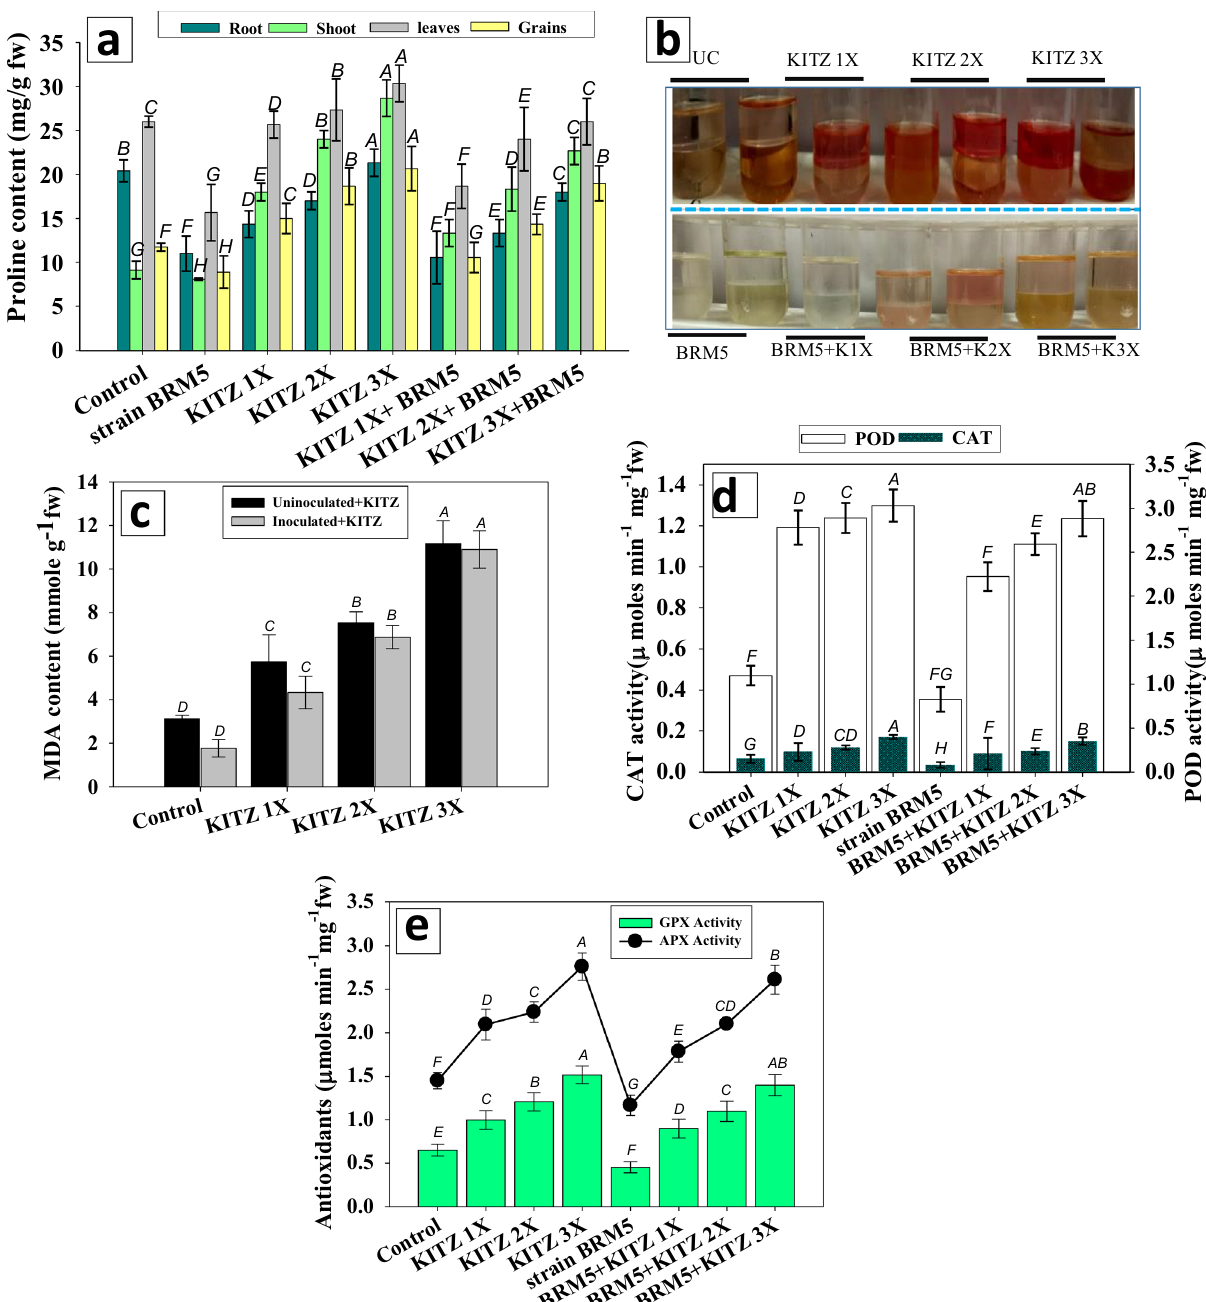
Figure 8. Bio-inoculation impact of M. ciceri BRM5 on proline content ( a ) antioxidant enzymes: GPX ( b ), APX ( c ) CAT ( d ) and MDA content ( e ) of C. arietinum plants grown in sandy clay loam soil treated with 96 (1 ×), 192 (2 ×) and 288 (3 ×) µg KTZ kg −1 soil. The bar and line diagrams represent the mean ± S.D ( n = 3) of three replicates where each replicate constituted three plants/pot. Mean values followed by different letters are significantly different at p ≤ 0.05 according to DMRT arietinum root surfaces and consequent increase in plant growth was reported by other workers 90–92 . Bacterial components such as EPS, cell wall polysaccharides and extracellular bacterial proteins help bacteria to attach onto the root surface. Bacterial counts from the rhizosphere and rhizoplane at varying intervals of seeding, i.e., 80 and 120 DAS with different doses of KITZ, were determined. The CFU counts were significantly reduced over untreated control with increasing level of fungicide; however, strain BRM5 survived and colonized even at the higher dose of fungicide. The lower doses imparted lesser impacts on viable counts of bacteria. At 3 × KITZ, the rhizospheric CFU count of M. ciceri was 3.2 and 4.3 log CFU/mL as compared to 6.7 and 5.1 log CFU/mL (untreated control) at 80 DAS and 120 DAS, respectively (Fig. 9). Similarly, viable populations of rhizoplane bacteria had declined over the untreated control. As PGPR colonize root surfaces, they multiply and reproduce